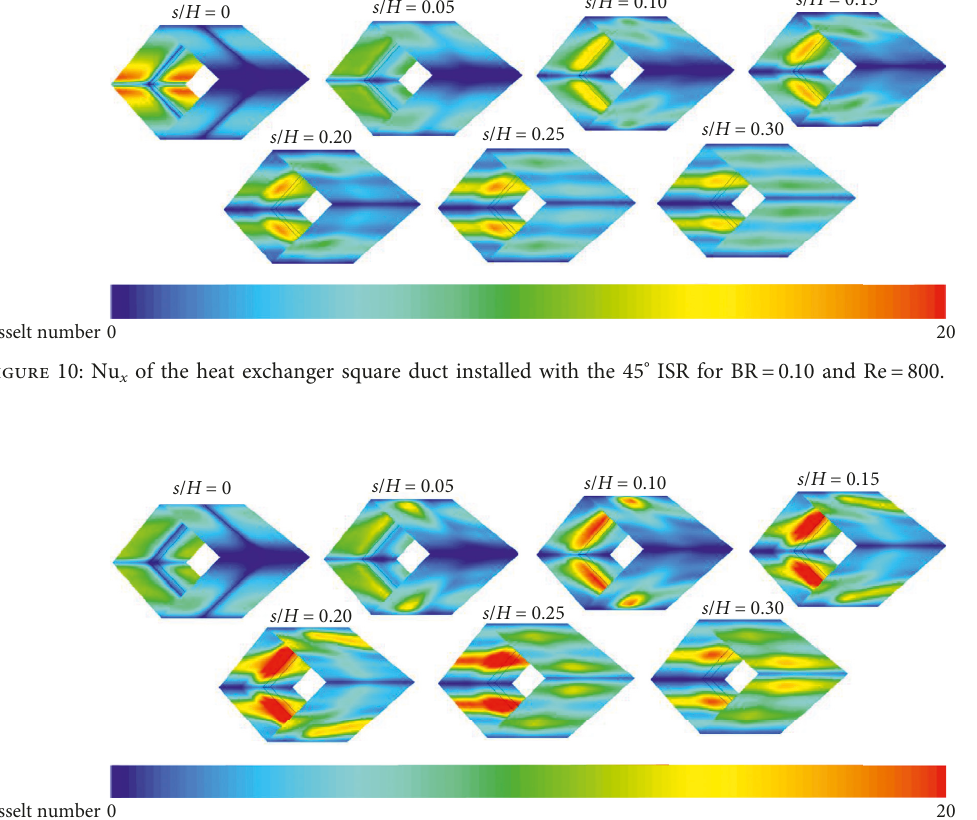
° ISR for BR � 0.15 and Re �